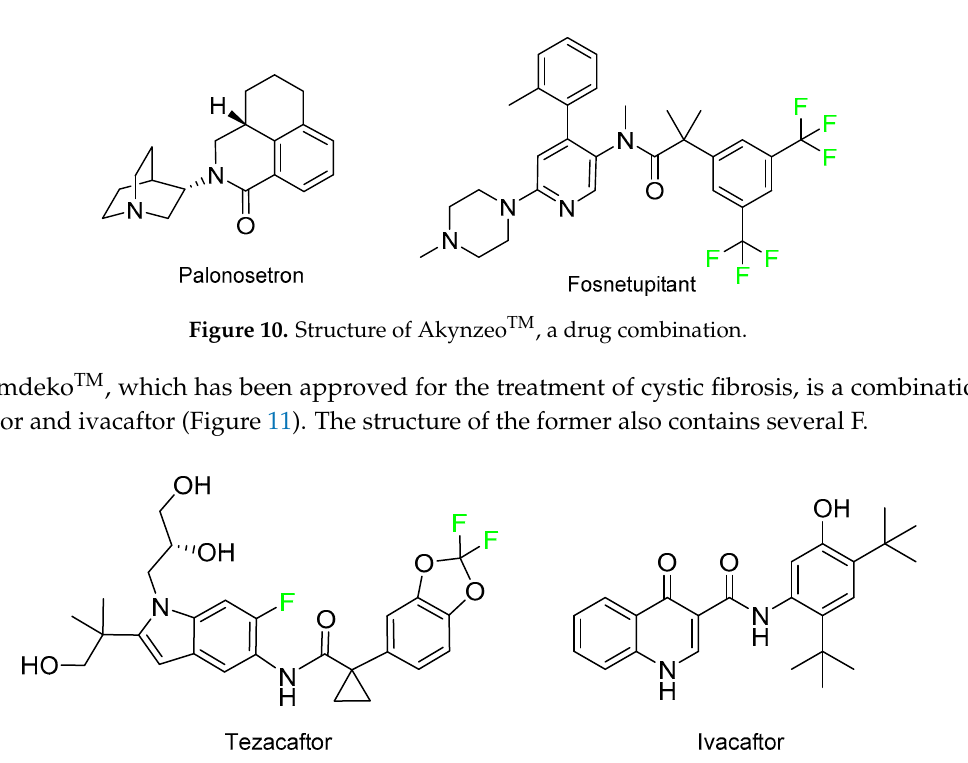
Figure 9. Structure of Biktarvy ™ , a drug combination.